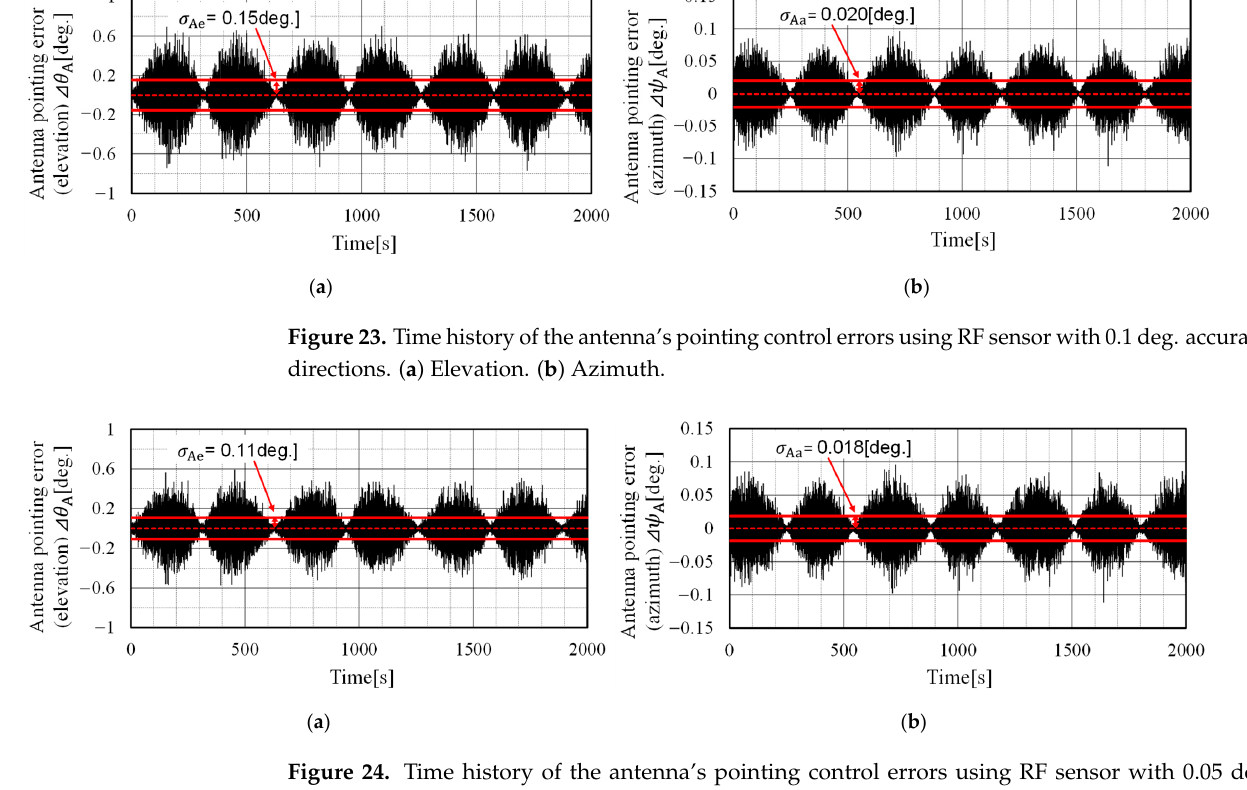
accuracy directions. ( a ) Elevation. ( b ) Azimuth.